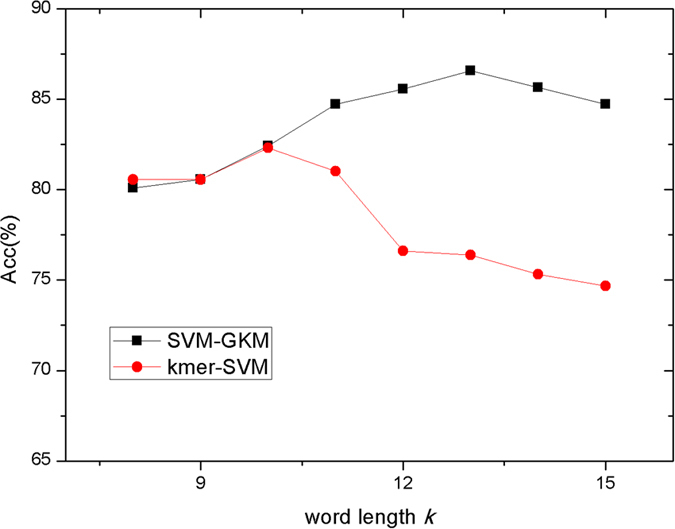
The influence of parameter k on the performance of two predictors.Two predictors, one is SVM-GKM, the other is kmer-SVM. We consider the word length k from 8 to 15, and choose the mismatch length m = 7 for SVM-GKM predictor. SVM-GKM achieves the highest result when k = 13, kmer-SVM obtains the highest result when k = 10.